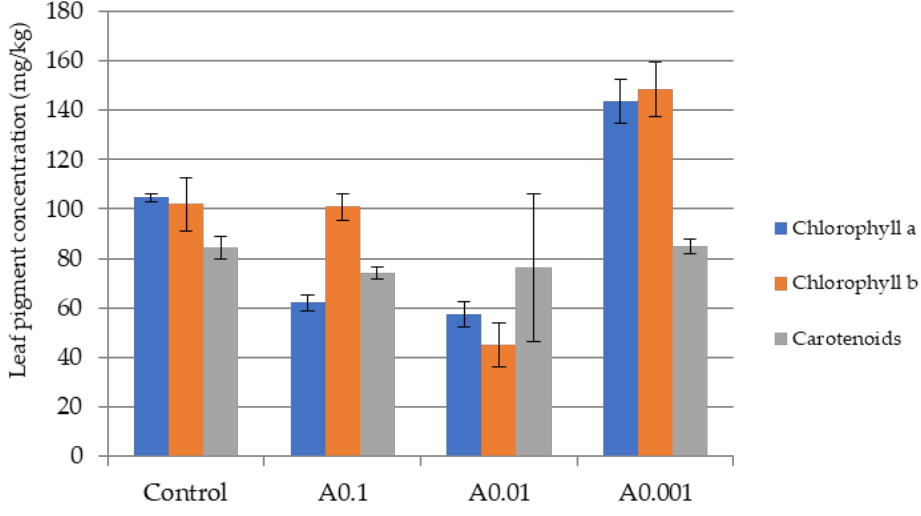
Figure 4. Average dry biomass of sorghum after 5 days of exposure.